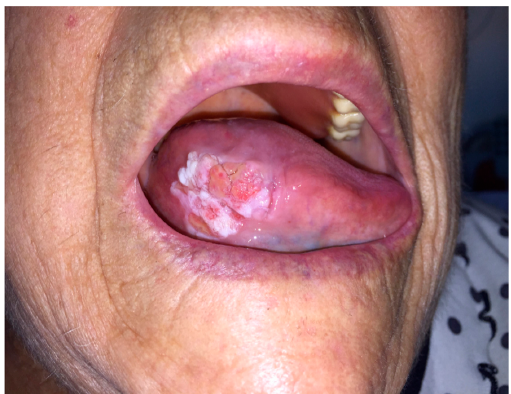
Figure 3. First visit in patient with right lingual margin neoformation.